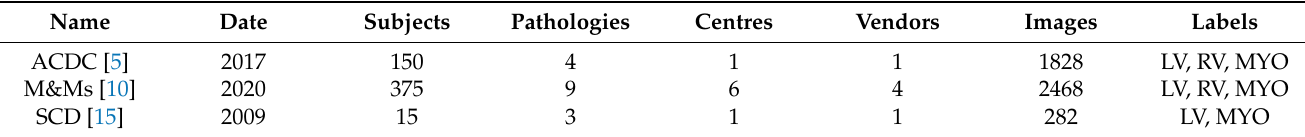
Table 1. Description of publicly available cine datasets used in this work, all published as workshop challenges for MICCAI. The number of images consists of 2D slices available for training. All datasets contain healthy subjects. The possible annotations are segmentation masks of the LV, myocardium (MYO), and